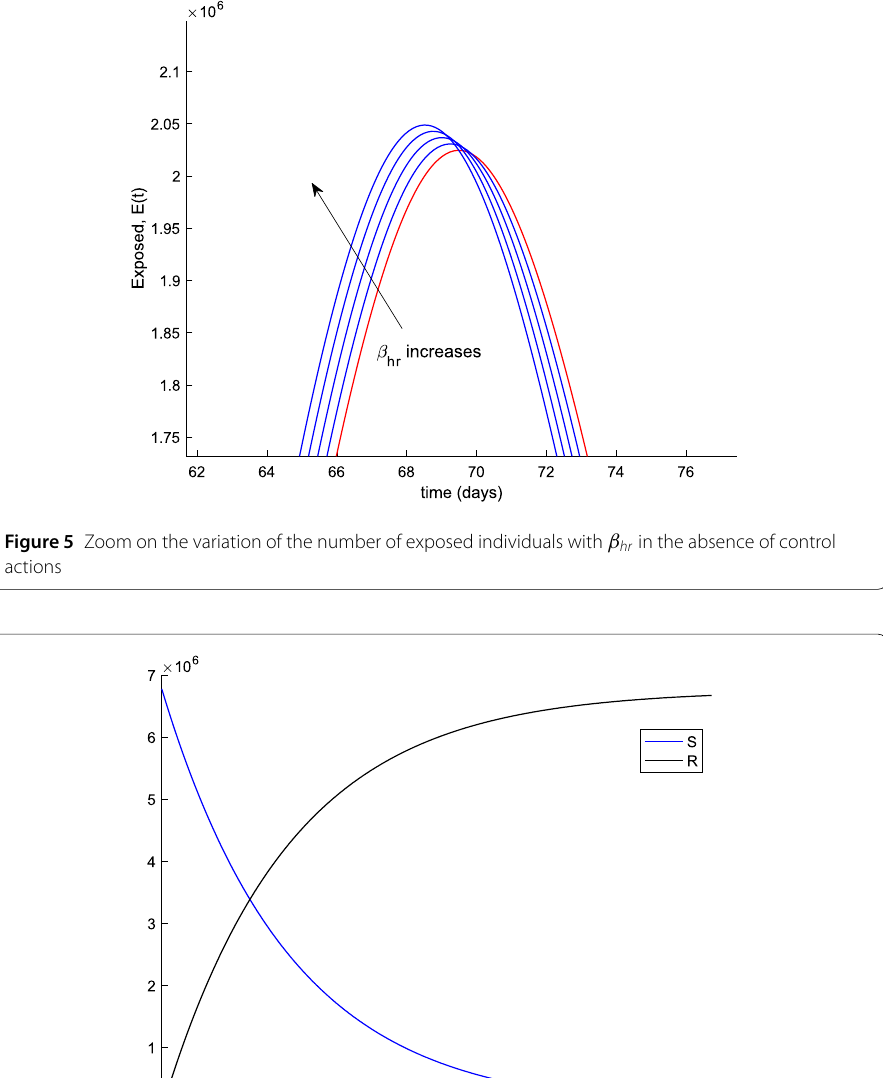
Now the value of k V is fixed to k V = 0.001, and the value of k T ranges from k T =